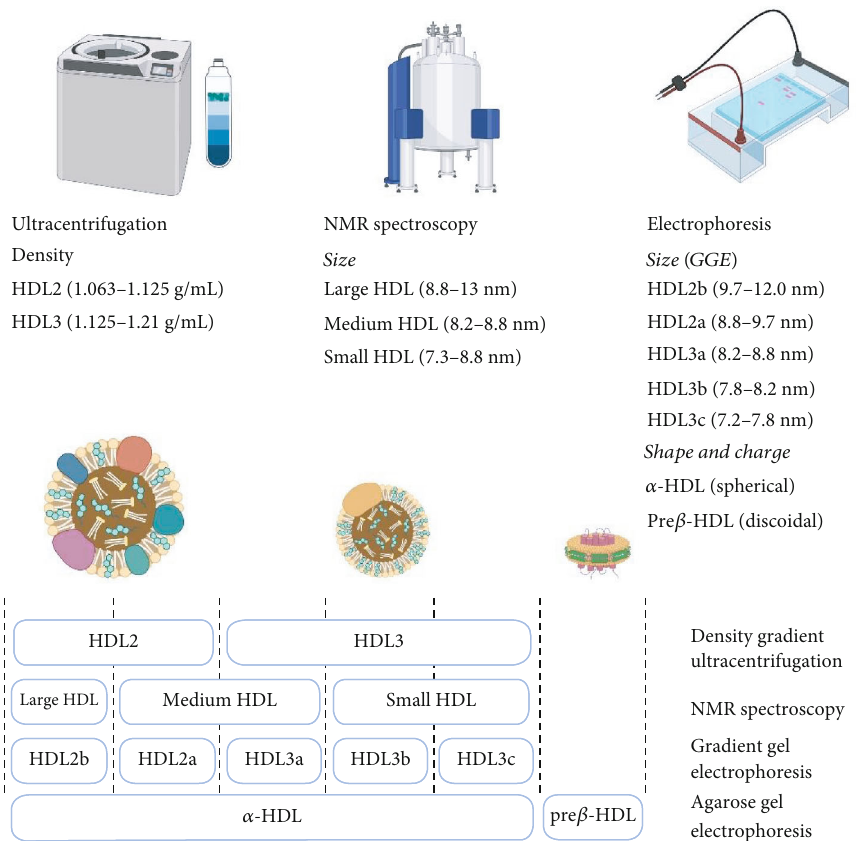
Figure 2: HDL subclasses characterized by di ff erent methods of separation. NMR: nuclear magnetic resonance; GGE: gradient gel